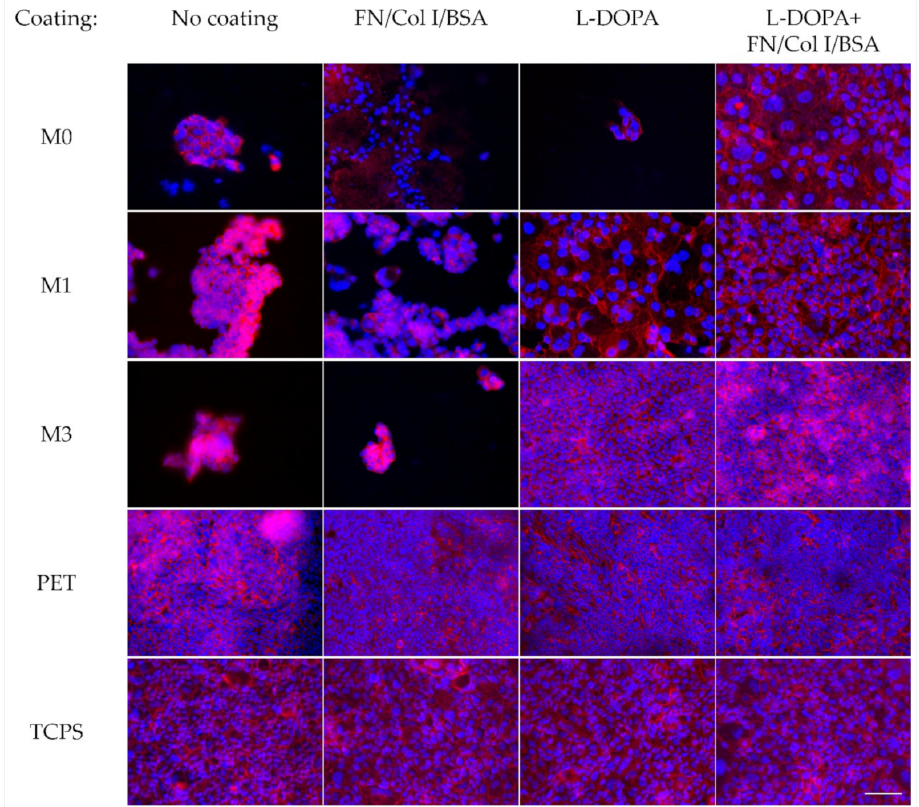
Figure 1. Cell nucleus (DAPI, blue) and F-actin (red) staining of Calu-3 cells grown for 8 days submerged and 2 weeks at air–liquid interface (ALI) on poly(trimethylene carbonate) (PTMC) and poly(ethylene terephthalate) (PET) membranes with different coatings. The latter membranes as well as tissue culture-treated polystyrene (TCPS) wells in which the cells were cultured submerged for 23 days, were used as references. Magnification: 200 × . Scale bar: 100 µ m, applies to all images. Samples originated from one experiment (N =